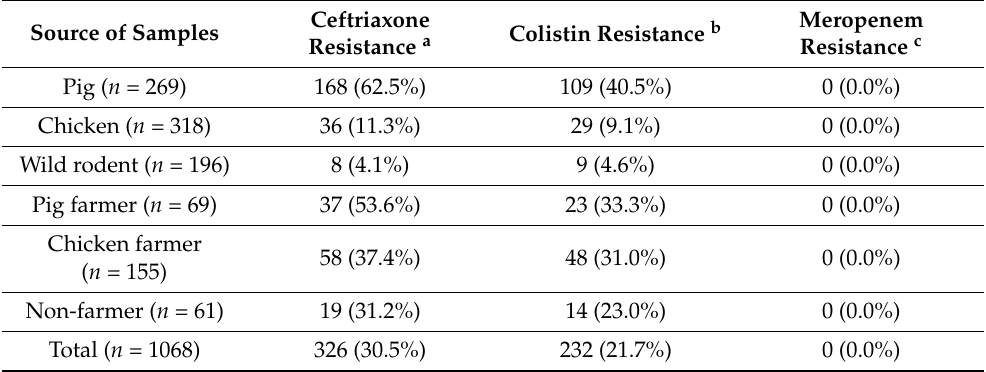
Table 2. Prevalence of ceftriaxone, colistin, and meropenem resistance in Escherichia coli isolated from samples collected from various animal and human sources. Ceftriaxone Source of Samples Colistin Resistance Resistance a